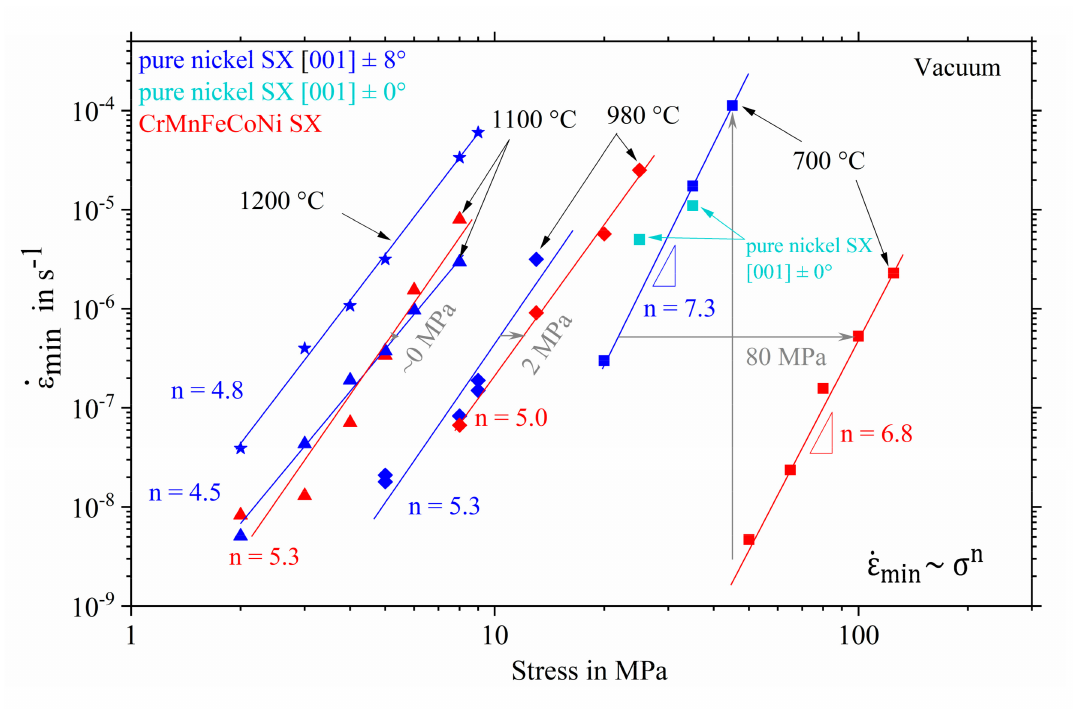
Figure 7. Double logarithmic scaling of minimum creep rate over stress of the single crystalline CrMnFeCoNi alloy in comparison to the single crystalline pure nickel (with 0 ◦ and 8 ◦ deviation from [001]) at 700, 980, 1100, and 1200 ◦ C under